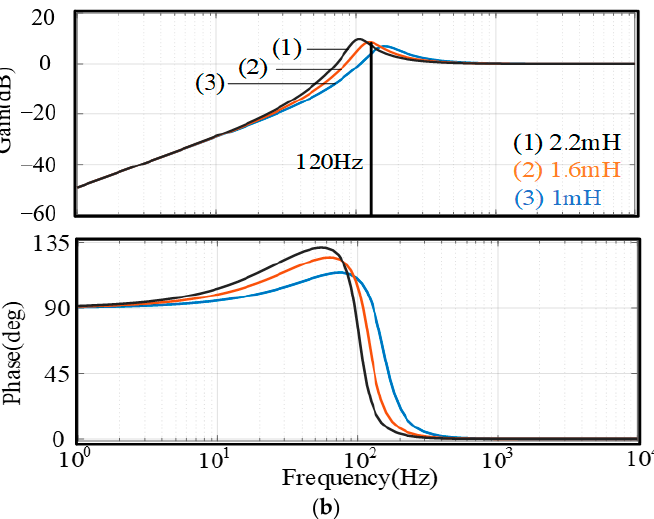
Figure 5. Bode plot of the transfer function in evaluation system proposed in [11]. ( a ) G 3 (s). ( b ) G 4 (s).